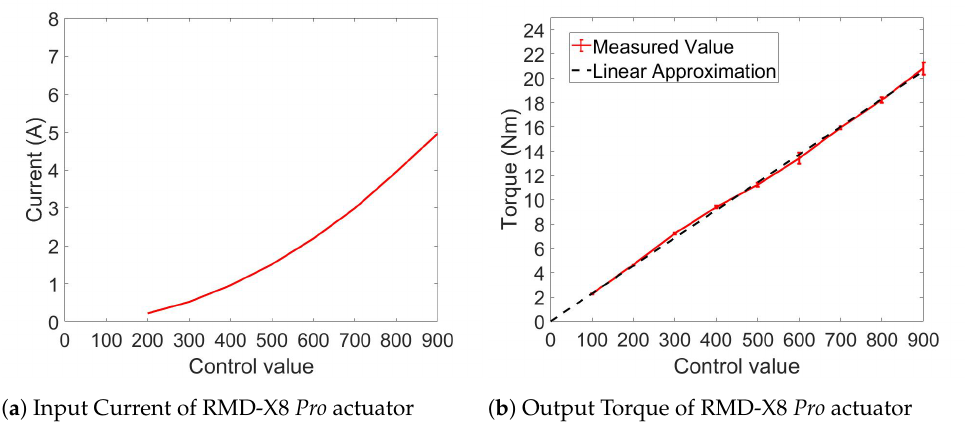
Figure 4. Input current and output torque over torque control value for RMD-X8 Pro